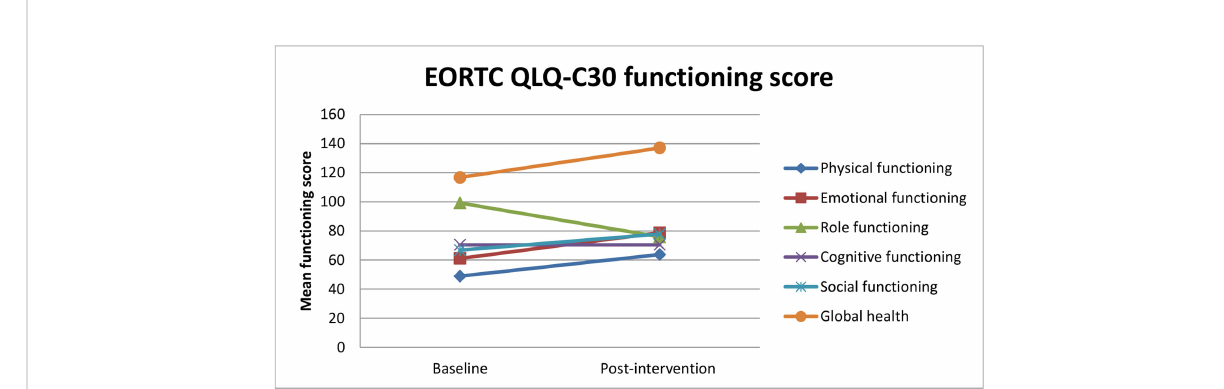
FIGURE 3 Estimated mean trajectories of quality of life functioning scores among breast cancer patients.